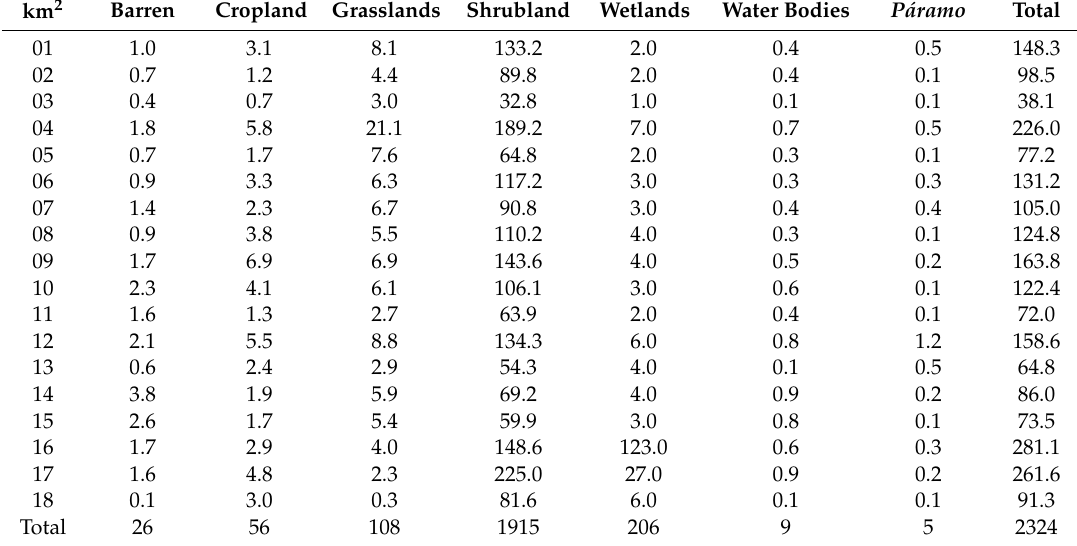
Table 5. Land cover classes (2018) associated with annual deforestation estimated by Hansen et al. [18] from 2001–2018 in square kilometers.